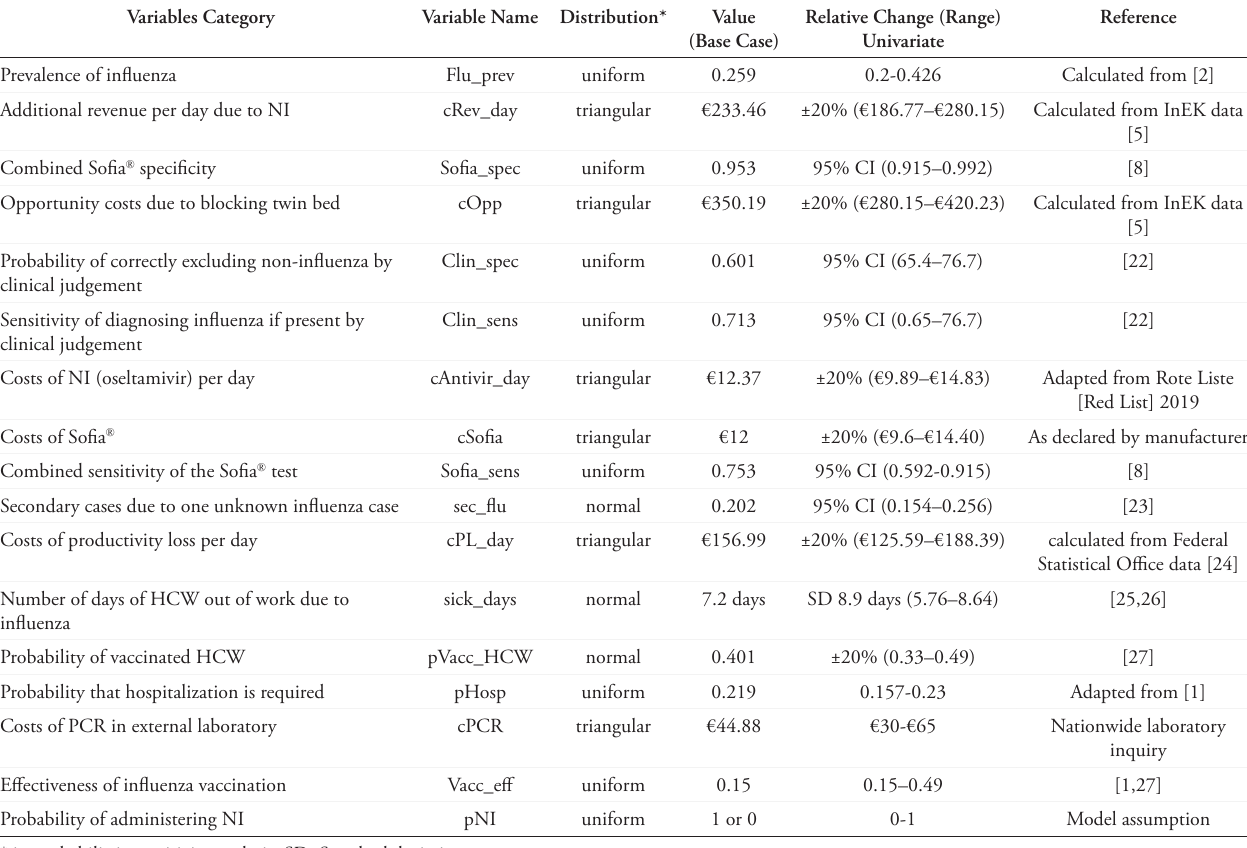
Table 1. Input for cost–benefit